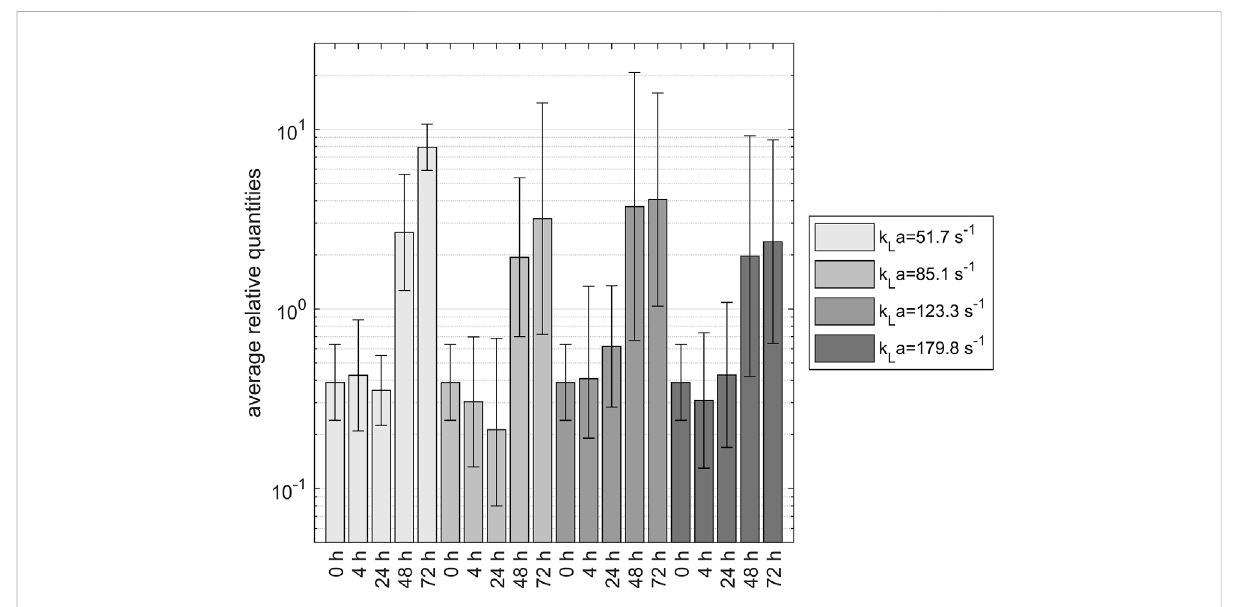
FIGURE 5 Relative expression of CTA1 gene during yeast propagation in shake fl asks, including the 95% con fi dence interval. The data show increased expression of the CTA1 gene after 48 h.